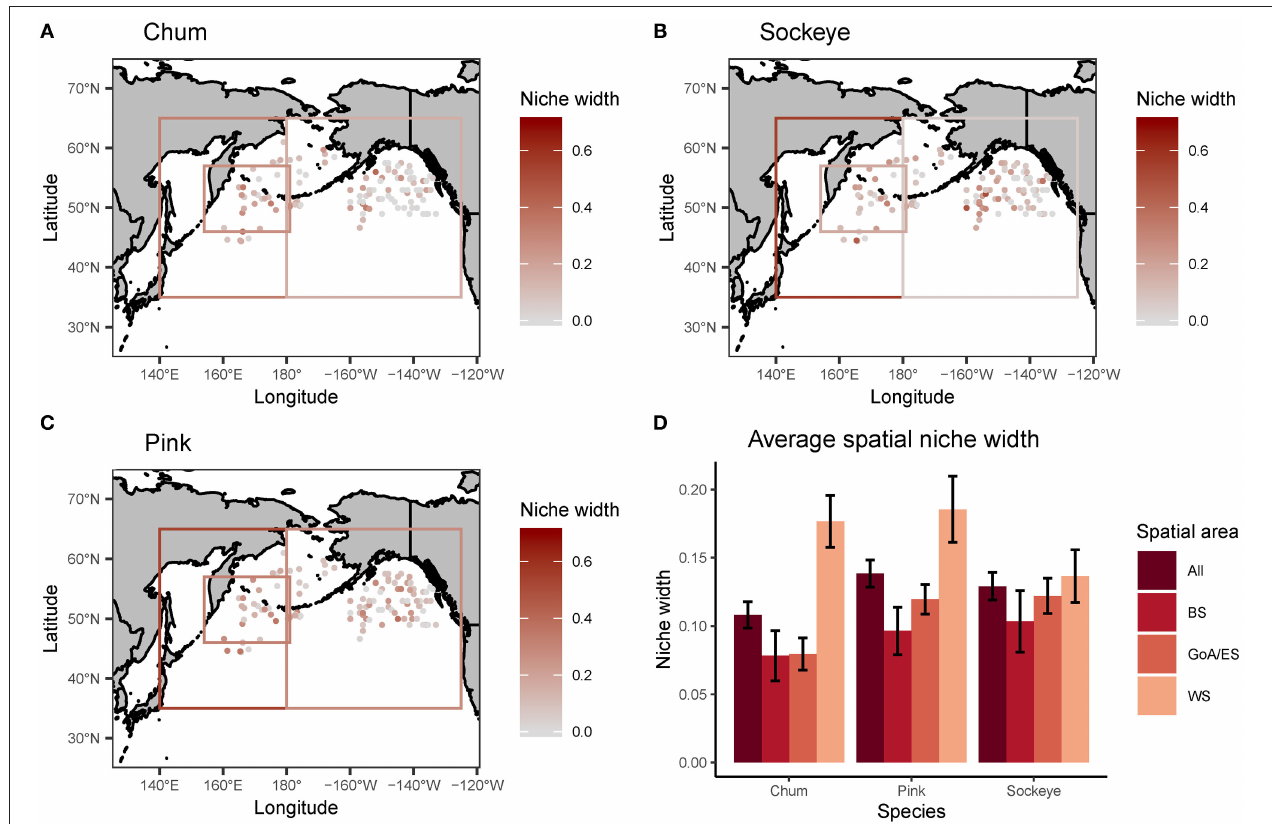
FIGURE 6 | A spatial map of trophic niche width, reported using Levin’s standardized measure, for (A) chum, (B) sockeye, and (C) pink calculated for each site where chum, sockeye, and pink were collected together at the same time. Additionally, the average spatial niche overlap for the entire North Pacific (All) and broken down by three regions (BS, Bering Sea; GoA/ES, Gulf of Alaska/Eastern Subarctic; WS, Western Subarctic) are displayed with standard error bars (D) . The boxes on the maps in (A–C) represent data reported for an area, as opposed to precise spatial